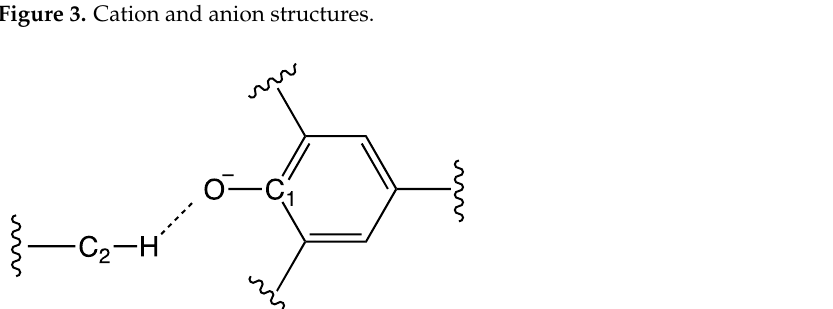
Figure 3. Cation and anion structures.